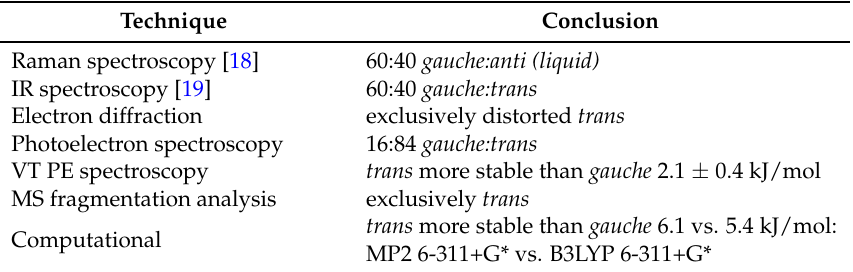
Table 1. Conflicting conclusions from literature regarding the rotational configuration of 2 a